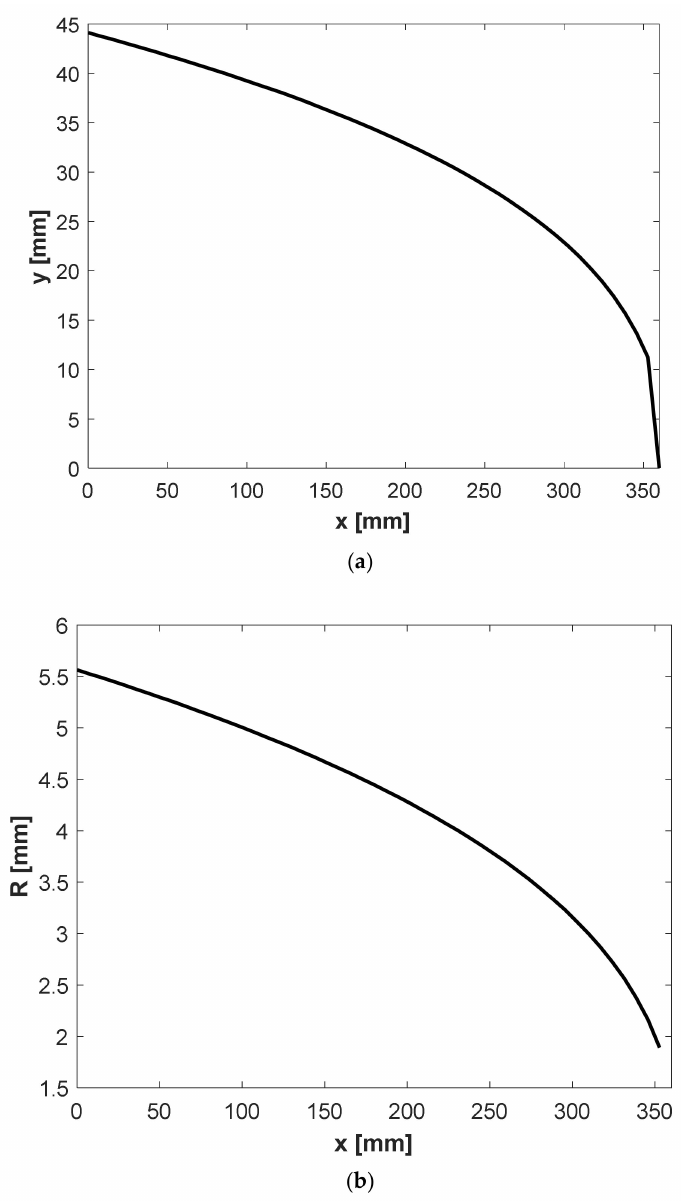
Figure 8. ( a ) Change of design parameter y ( x ) with respect to x and ( b ) change of the manifold radius R with respect to x for Carreau–Yasuda polypropylene (parameters in Table 2) using the proposed model with a circular